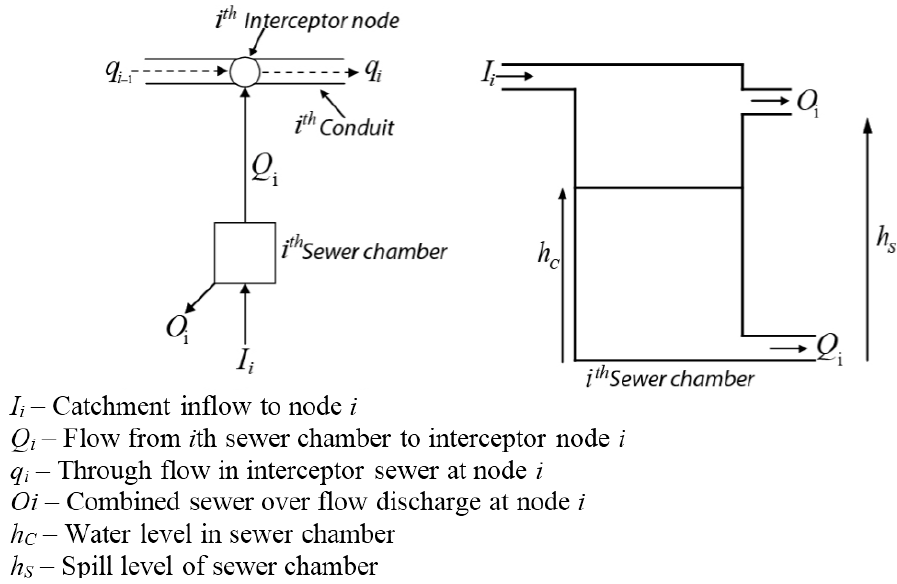
Figure 1. Schematic diagram of interceptor sewer